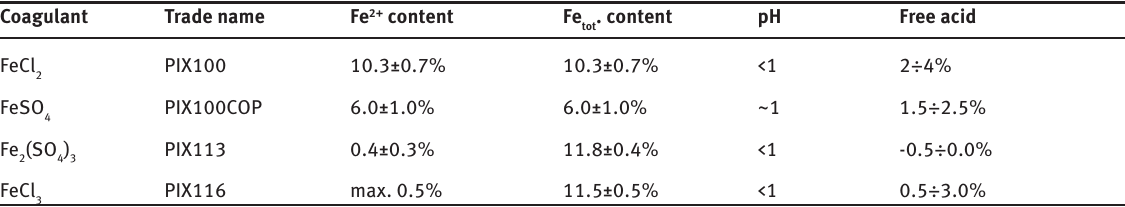
Table 2: The characteristics of coagulants used in the research. Coagulant